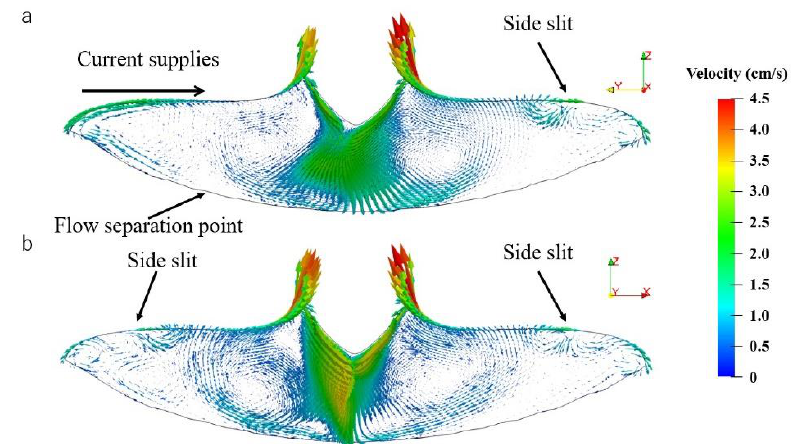
Figure 7. Flow field in the melt: ( a ) cross section in the X plane (in the vicinity of the current supplies); ( b ) cross section in the Y plane (perpendicular to the main slit). The flow separation point is indicated, where the two major vortices meet at the solid–liquid interface.